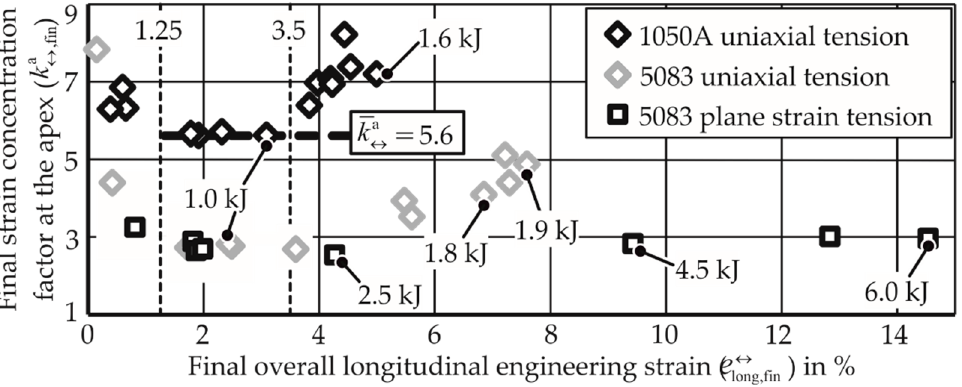
Figure 21. Strains measured after electromagnetic forming limit tests. Each point represents a test. Values in kJ reveal the input energy of the